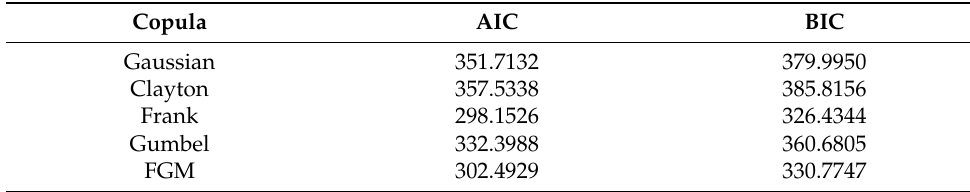
Table 2. AIC and BIC values for different copula functions.